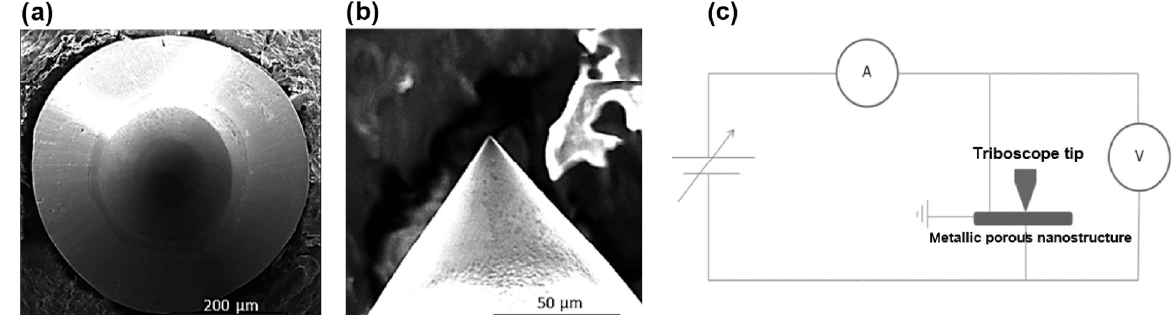
Fig. 2 SEM images of the conical indenter tip. (a) Top view of the conical tip, (b) side view of the conical tip, and (c) schematic setup for nanoindentation with applied electric